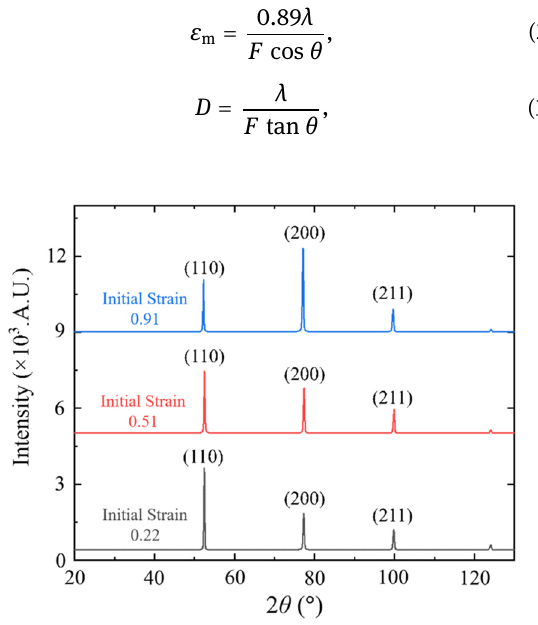
Figure 2: XRD patterns of the samples with di ff erent initial